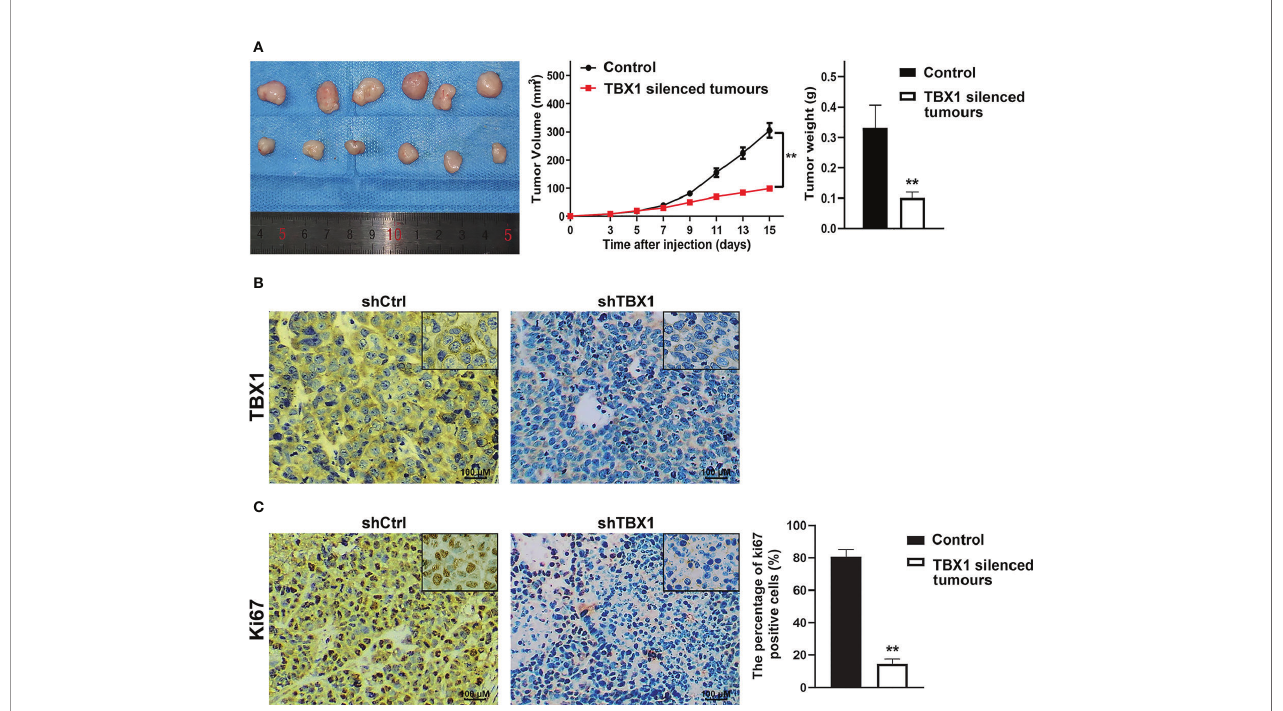
FIGURE 4 | TBX1 silencing decreases the growth of implanted PCa cells tumors in vivo (A) Left panel, photographs of tumors implanted with TBX1-silenced DU145 cells and control tumors from nude mice. Middle panel, tumor growth curves of the TBX1-silenced and control groups. Right panel, histogram of mean tumor weights. The data are shown as mean ± SD (n = 6/group). (B) Representative TBX1 staining of xenograft tumors obtained from the TBX1-silenced and control groups. (C) Left panel, representative Ki-67 staining of xenograft tumors obtained from the TBX1-silenced and control groups. Right panel, histogram representing the percentage of Ki-67-positive cells from fi ve microscopic fi elds of the TBX1-silenced and control groups. The data are shown as mean ± SD (n = 6/group). ** p < 0.01, shTBX1 silencing tumors vs control.